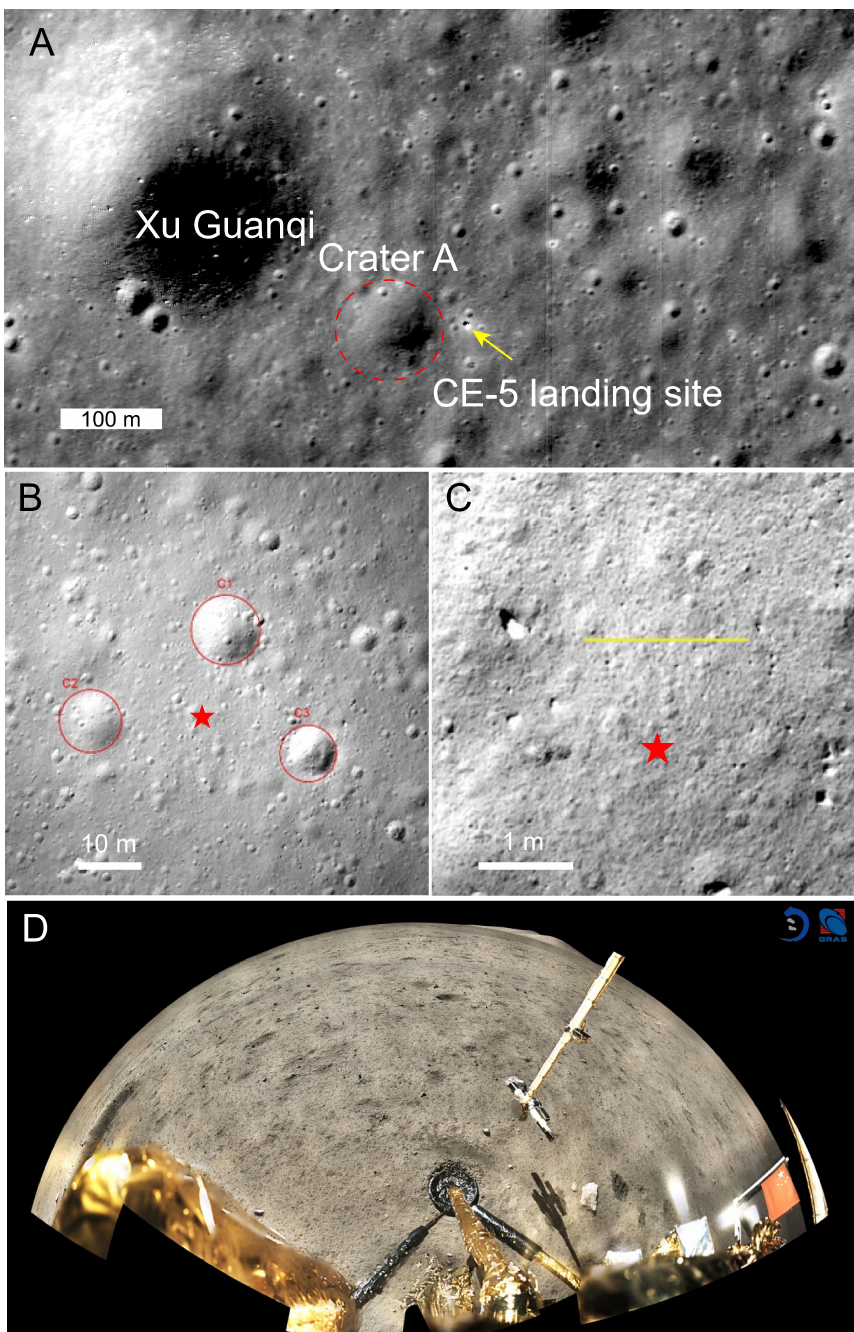
Figure 1. Geological background of Chang’E-5 landing site. ( A ) The Chang’E-5 lander is located on the Eratosthenian-aged mare basalt on the near side of the Moon. The dashed red circle indicates the position of Crater A, which has a diameter of ∼ 104 m and a depth of ∼ 7 m (Su et al. [31]). The base image is from LROC NAC data with a resolution of 1.5 m/pixel (Image ID:M1361560086RE). ( B ) The lander is surrounded by three small craters (C1, C2, and C3); the base image was acquired by Chang’E-5 landing camera, which has a resolution of 5 cm/pixel. ( C ) The yellow line represents the LRPR survey line, and is approximately 1.56 m. The red star indicates the position of the lander. The base image is from the Chang’E-5 landing camera, which has a resolution of 1 cm/pixel. ( D ) Image of the lunar surface acquired by the lander camera; the image is shows the distribution of a small amount of rock fragments. The images acquired by Chang’E-5 can be freely download from https://moon.bao.ac.cn/ce5web/moonGisMap.search, accessed on 2 August